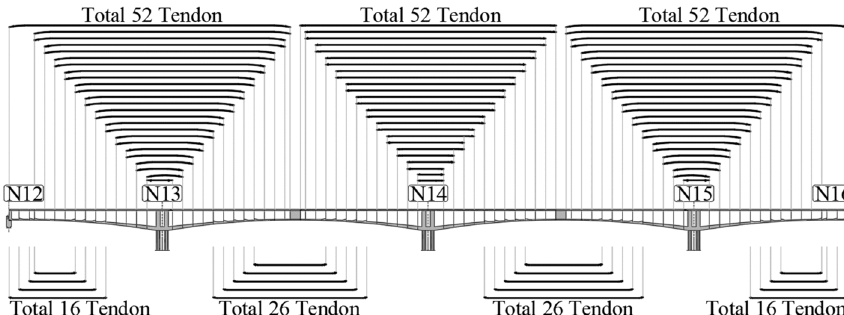
Fig. 13 Longitudinal prestressing layout of Girga